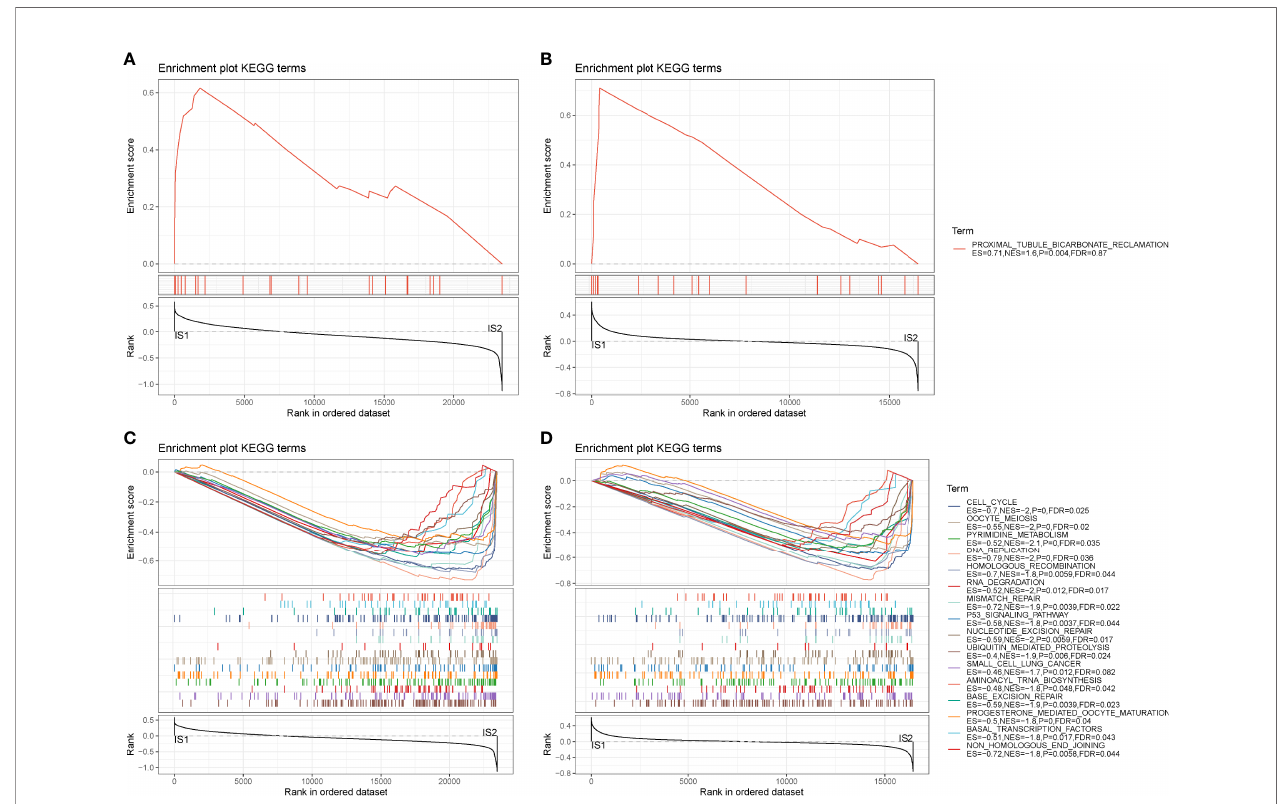
FIGURE 4 | GSEA of hallmark pathways in TCGA-PAAD and GEO cohorts. (A, B) Enriched pathways of IS1 in TCGA-PAAD (A) and GEO (B) cohorts. (C, D) Enriched pathways of IS2 in TCGA-PAAD (C) and GEO (D)